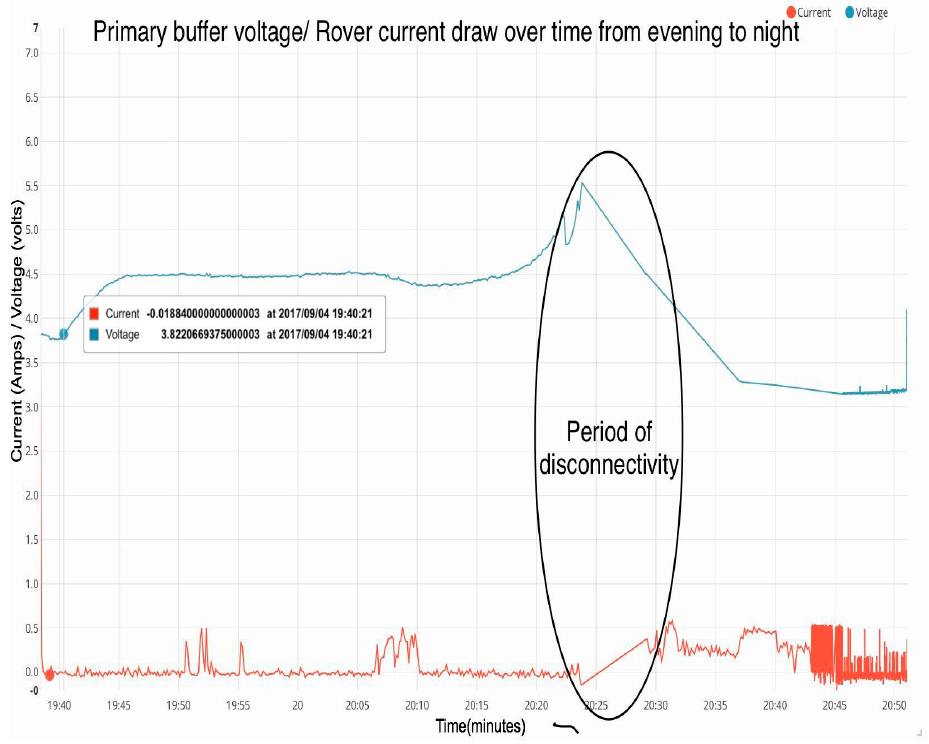
Figure 5. Rover outdoor test during evening hours from sunset into the night.